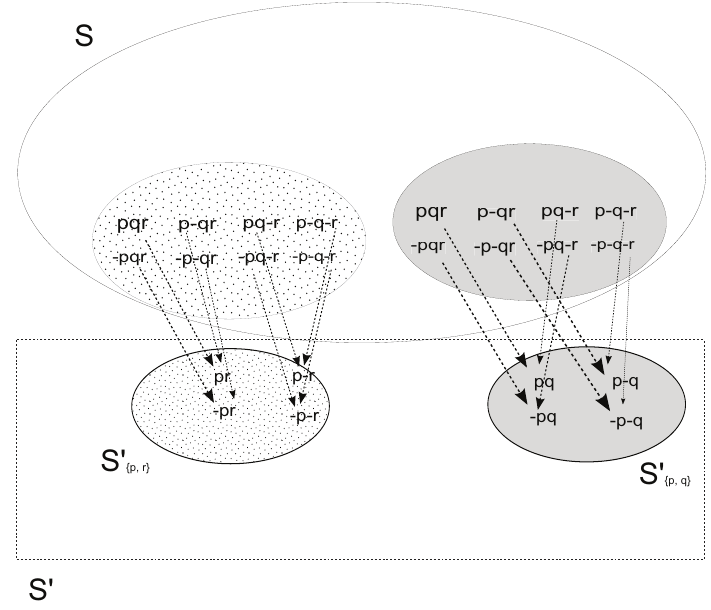
Figure 4. Partial picture of a generalized standard structure